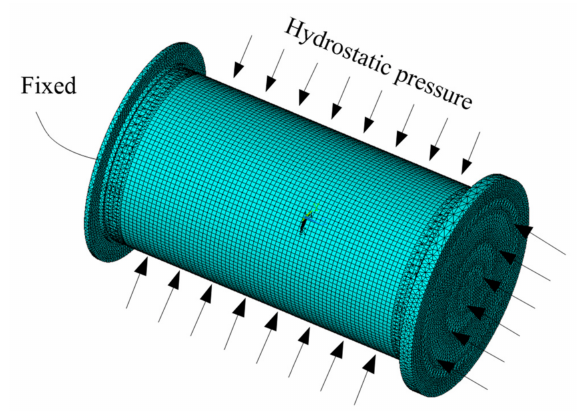
Figure 3. Finite element model and boundary